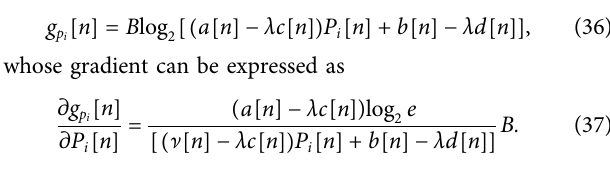
dots represent ground users, and the green